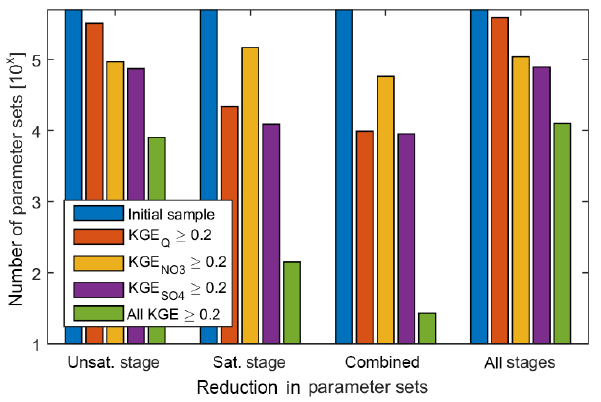
Figure 4. Reduction in the initial sample by the four soft rules for the unsaturated state, saturated state, combined saturated and satu- rated states, and all system